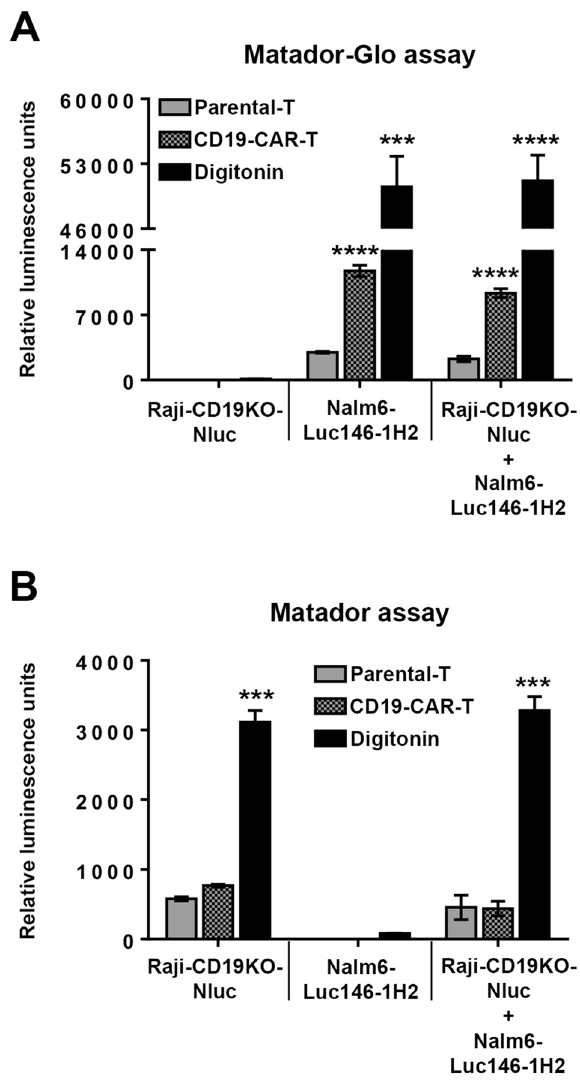
Figure 7. Utility of the Matador-Glo assay in a multiplex cytotoxicity assay. ( A ) Raji cells lacking CD19 expression and stably expressing Nluc (Raji-CD19KO-Nluc) and CD19-positive Nalm6 cells stably expressing Luc146-1H2 (Nalm6-Luc146-1H2) were either plated alone or in combination at 1:1 ratio. The plated cells were co-incubated with parental-T cells or T cells expressing the CD19-CAR (CD19-CAR-T) at an Effector:Target (E:T) ratio of 1:1 for 24 h in a 24-well plate. For maximum cell death, 30 µg/ml digitonin was added an hour prior to luciferase assay. Post-incubation cell homogenates were carefully transferred to a 384-well plate to measure Luc146-1H2 activity (Matador-Glo assay) using D-luciferin containing assay buffer. ( B ) The same samples mentioned in ( A ) were used to measure Nluc activity (Matador assay) using coelenterazine containing assay buffer. The values shown are mean ± SE of a representative experiment performed in triplicate for at least two times. Statistically significant differences are shown by asterisks (***) at a level of P < 0.001 and (****) at a level of P <